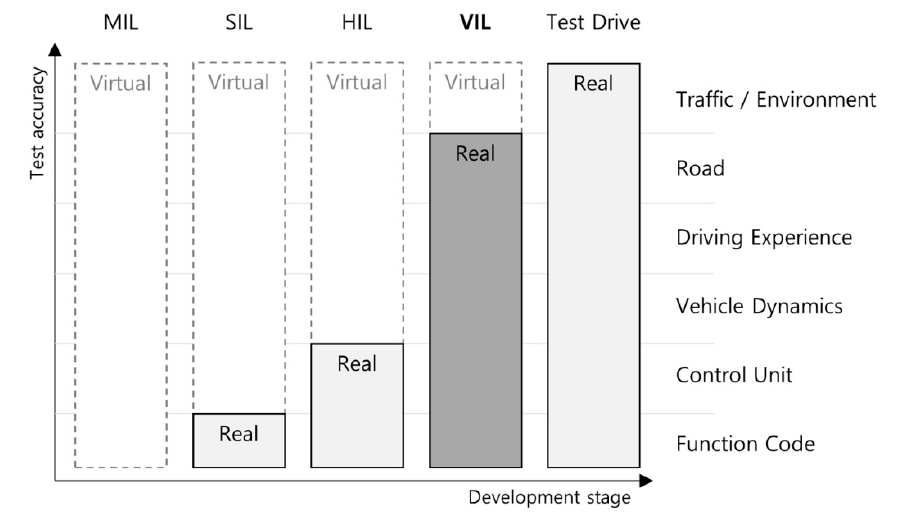
Figure 1. MIL vs. SIL vs. HIL vs. VIL vs. Test Drive.